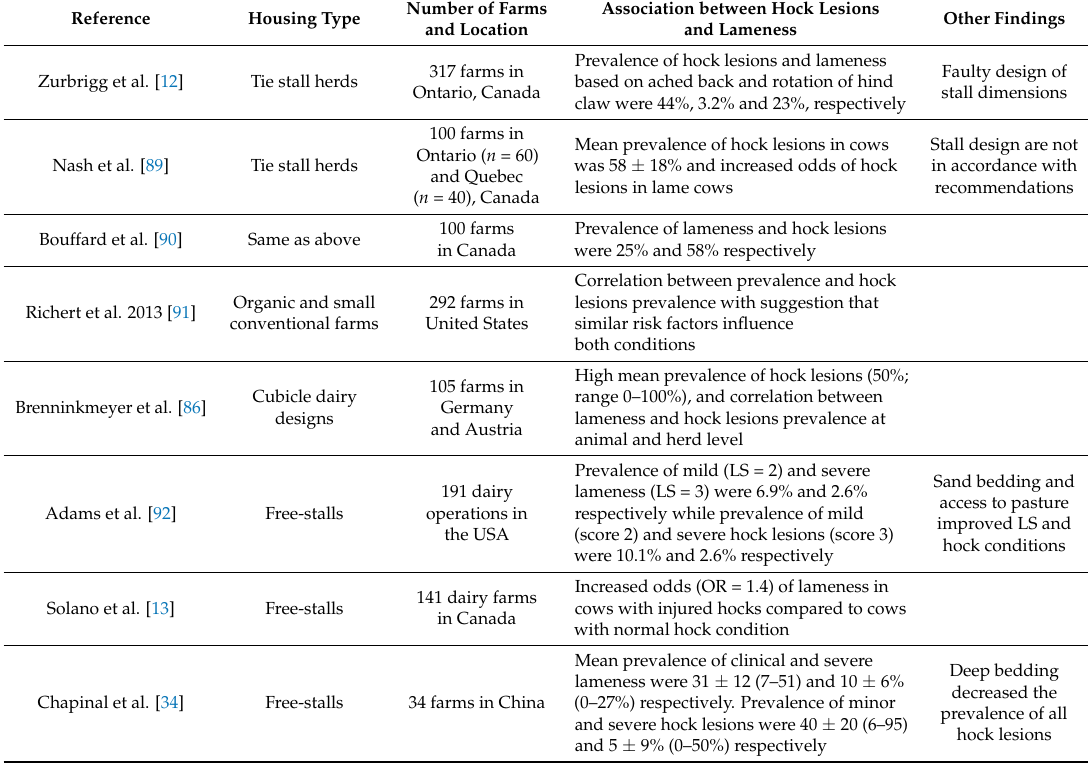
Table 2. Selected studies and findings involving the association between lameness and hock lesions in dairy